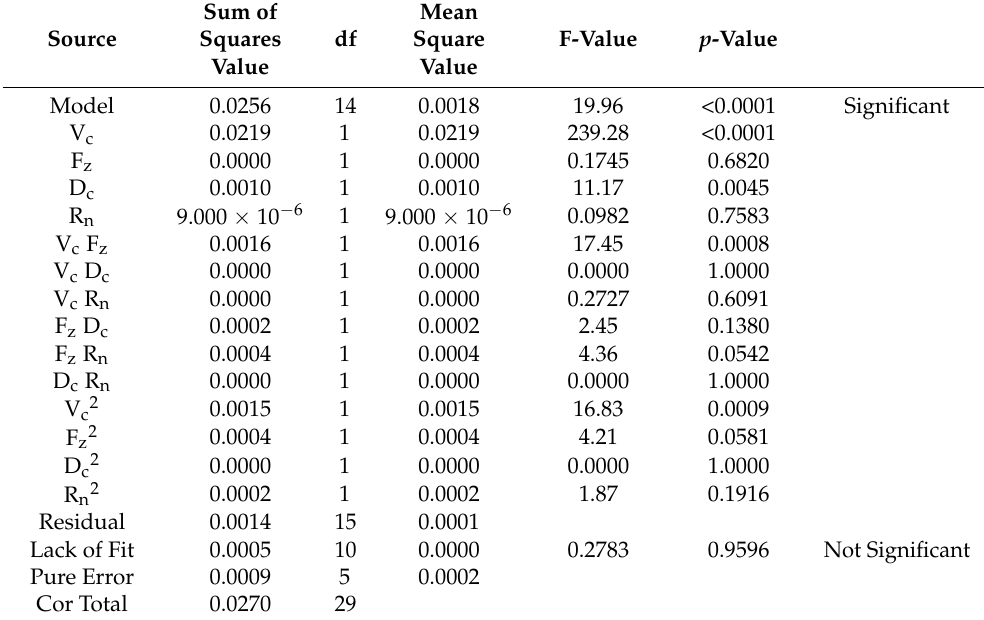
Table 4. Surface roughness—ANOVA table. Sum of Source